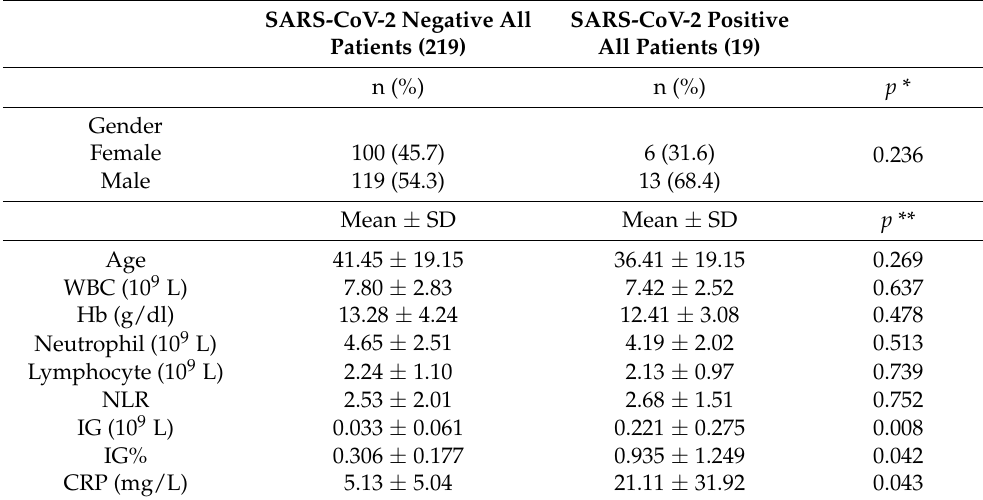
Table 1. Comparison of laboratory data of patients with and without SARS-CoV-2 infection. SARS-CoV-2 Negative All